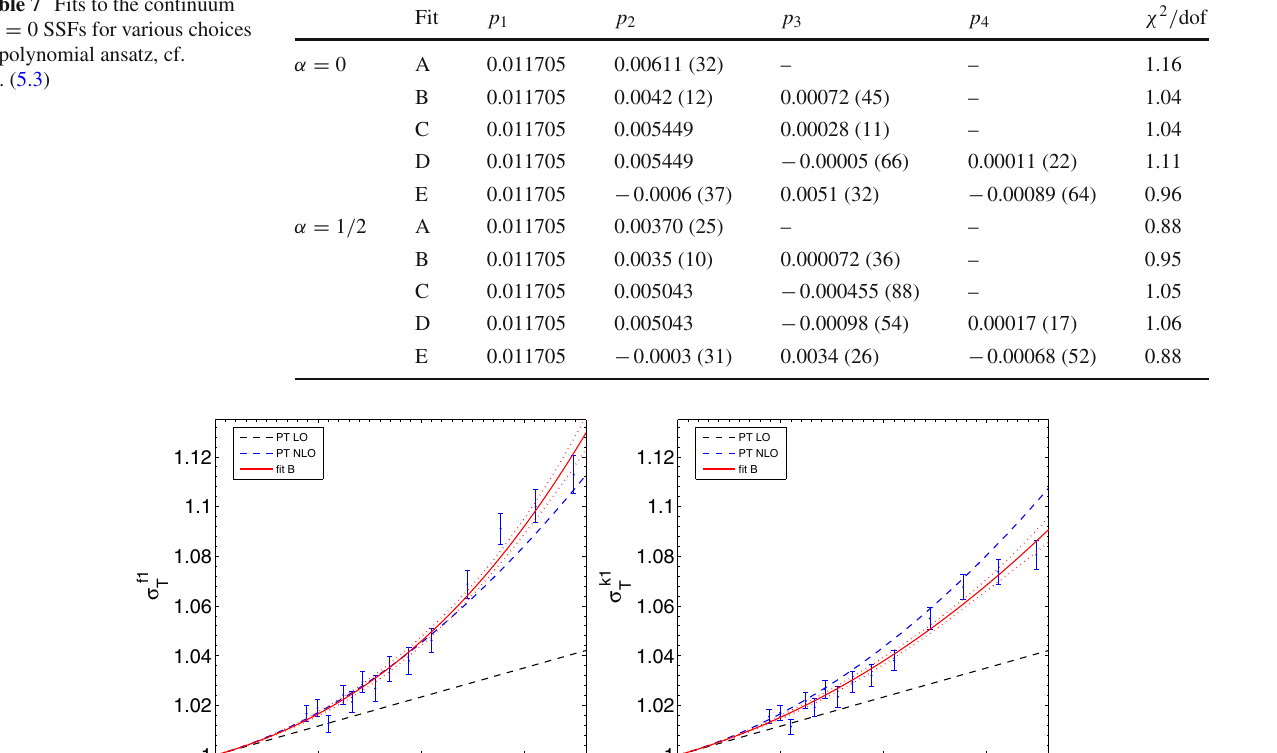
Table 7 Fits to the continuum N f = 0 SSFs for various choices of polynomial ansatz, cf.